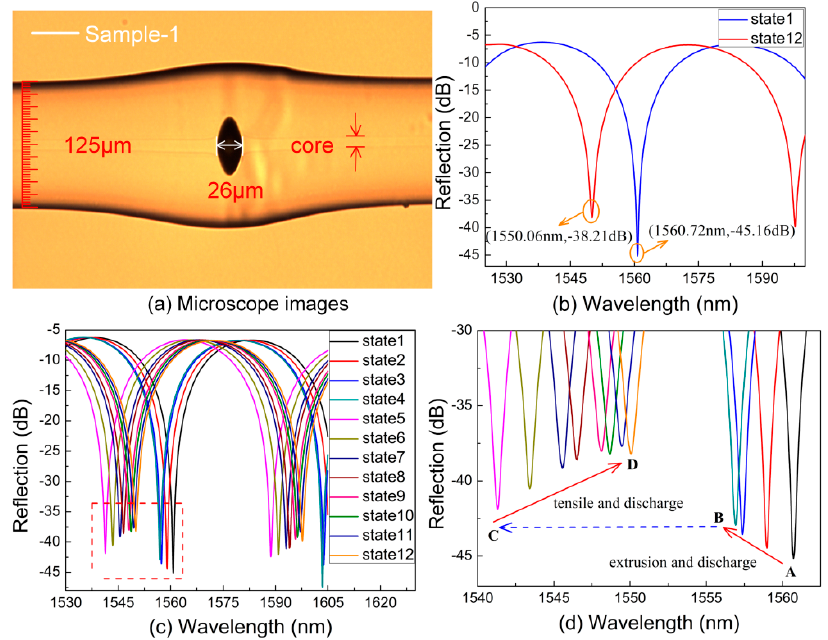
Figure 1. ( a ) Microscope images of the in-fiber Fabry–Perot interferometers (FPI) with a cavity length of 26 µ m. ( b ) The reflection original spectrum and the final spectrum. ( c ) The dip wavelength of reflection spectra at the same arc discharge states (state 1–12). ( d ) Enlarged the view of the dotted box.